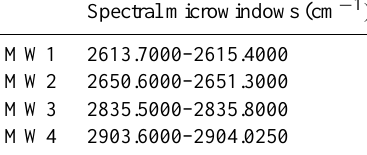
Table 2. Assumed random and systematic uncertainties. It is as- sumed that 80% of the values listed in the table below correspond to random uncertainties and 20% to systematic uncertainties (ex- cept for spectroscopy that is assumed to be 100%